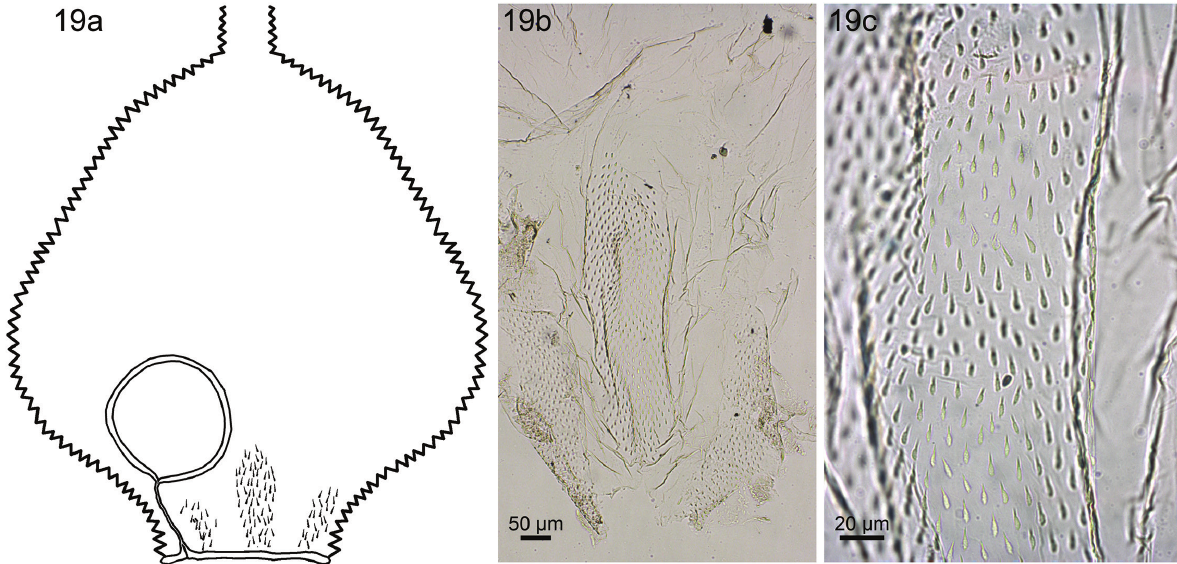
Figure 19. Procornitermes lespesii . (a) Schematic drawing of P1 showing arrangement of spines. (b, c) Photomicrographs: (b) General view showing three proximal sets of small spines; (c) Small spines with sclerotized base in detail.